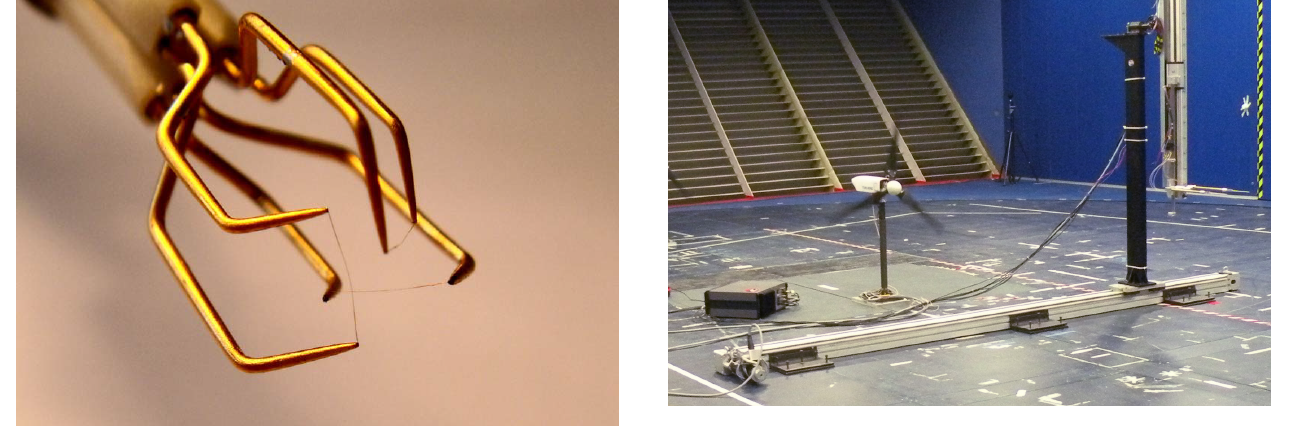
Figure 9. The traversing system for the hot-wire